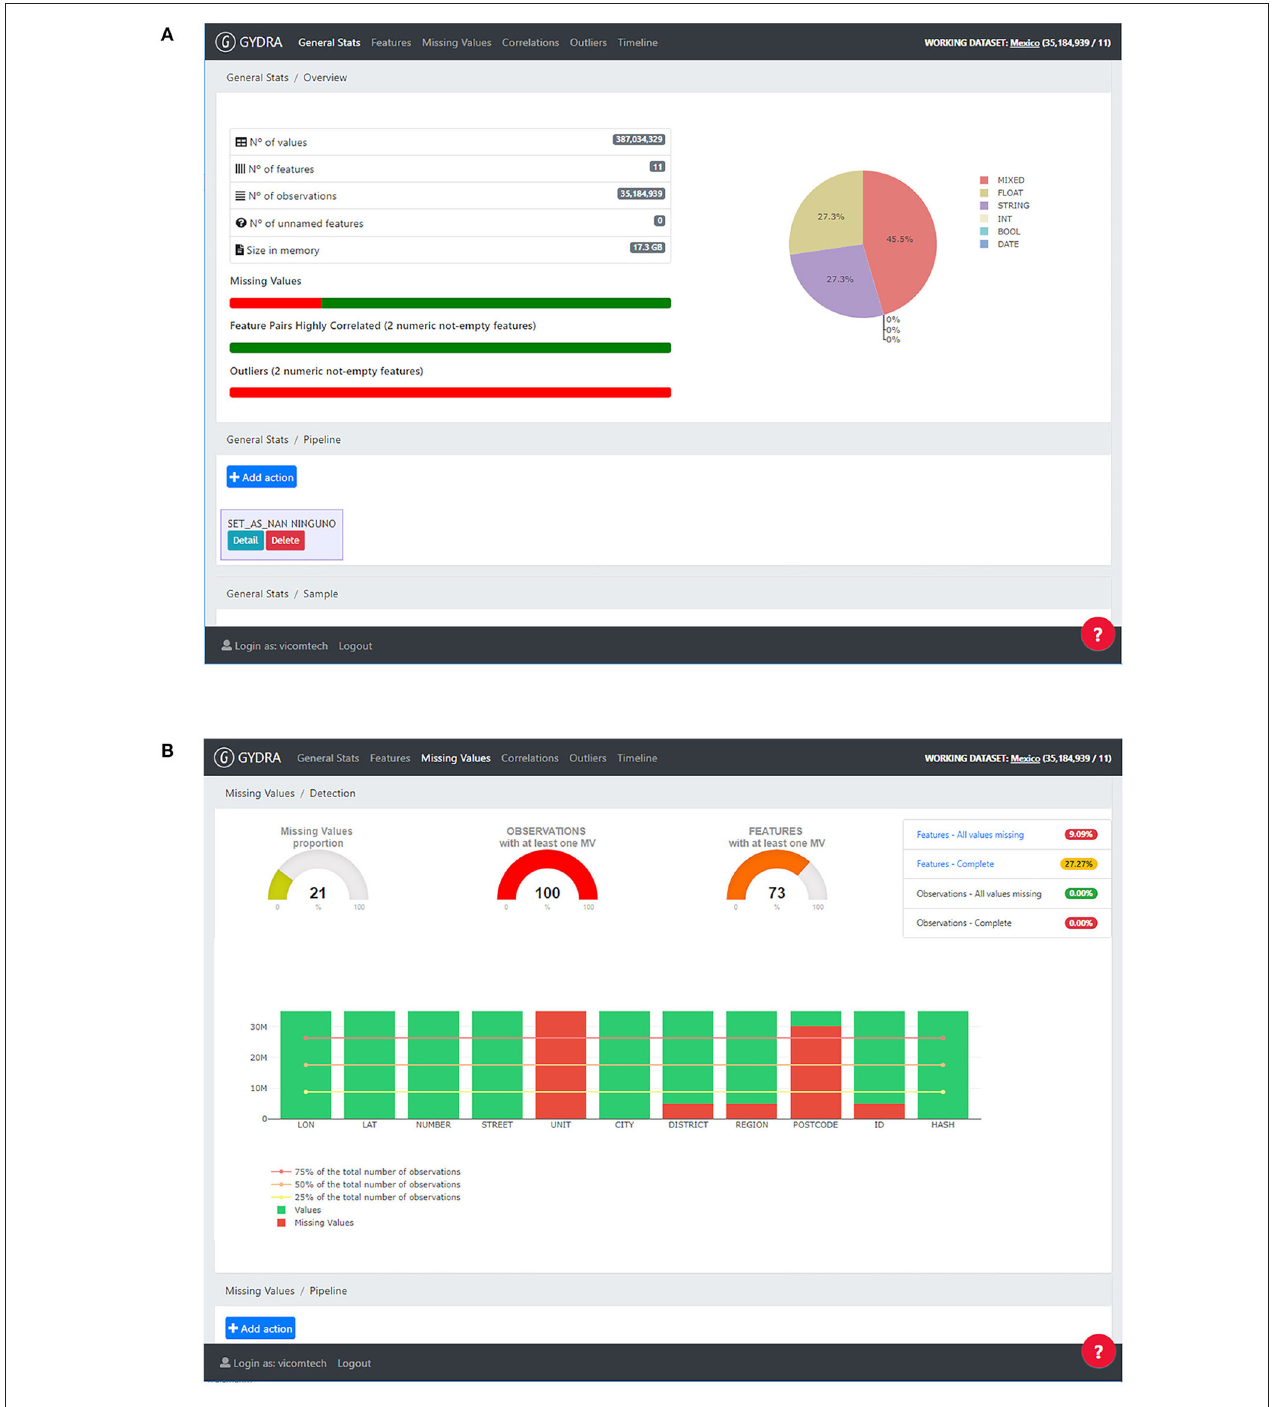
FIGURE 3 | GYDRA data preparation tool UI, provided through an easy-to-use tab-based navigation approach following a common data assessment and preparation steps (i.e., General Stats, Features, Missing Values, Correlation and Outliers analysis tasks). Screenshots for two representative sections are included: (A) General stats–On the left side, general statistics on features and observations are provided, on the right side the variables type distribution is shown on a pie chart. On the lower part a transformations pipeline is included to add dataset transformations as their need is identified. (B) Missing values–On the top left area, missing value proportion is depicted for values, features and observations, on the right side indicators for complete and completely empty features and observations is provided. On the lower part, each feature is analyzed separately on bar charts representing their missing value percentage. Reprinted by permission from Springer Nature Customer Service Centre GmbH: Springer Nature, Business Information System Workshops, Chapter Enhancing the Interactive Visualization of a Data Preparation Tool from in-Memory Fitting to Big Data Sets by (14).